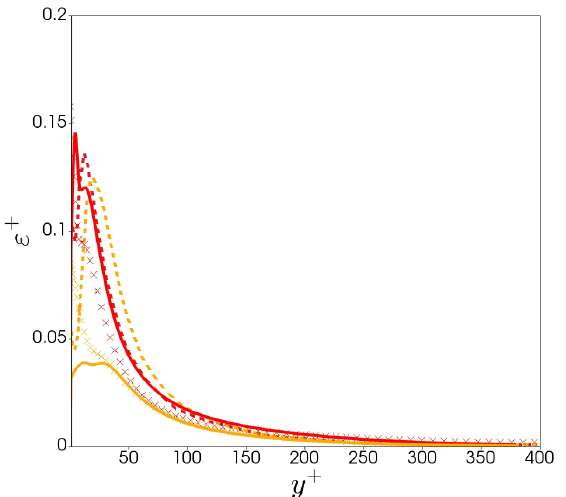
Figure 5. Comparison of the rate of Newtonian dissipation of k between DNS data ( × crosses) and predictions with the new model (continuum lines), and v 2 − f model of Masoudian et al. [28] (dash lines). Each colour represents a different drag reduction regime: red (LDR case 16); orange (HDR case 22).